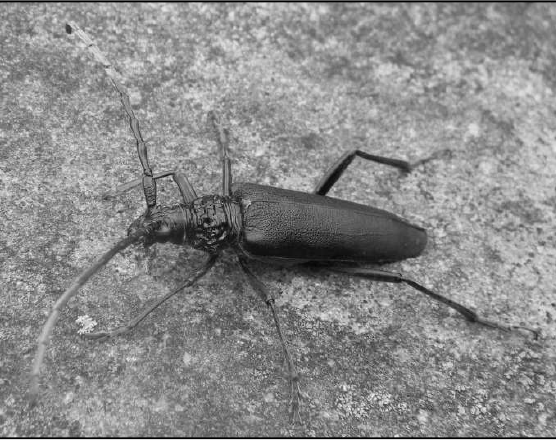
Figure 2. Cerambyx ( Cerambyx ) cerdo cerdo Linnaeus, 1758 (photo Filip Vukajlovi ć ,